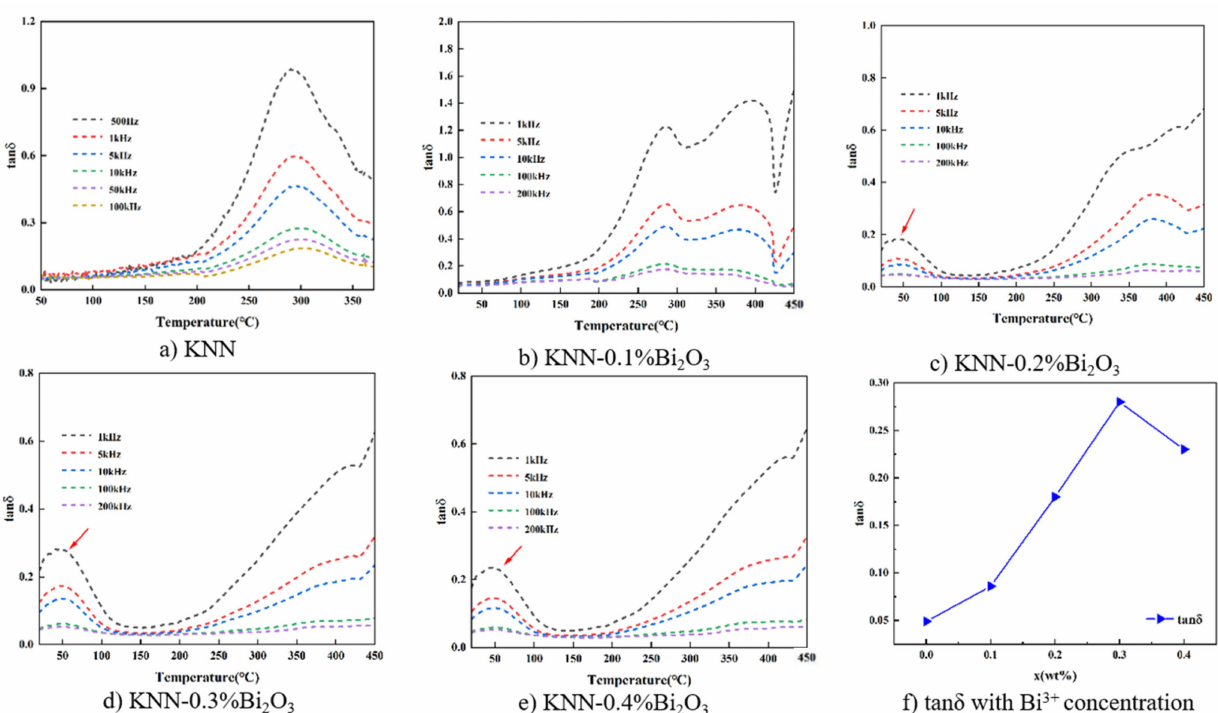
Figure 5. Temperature dependence of dielectric loss tan δ for KNN-x%Bi 2 O 3 (x = 0.0, 0.1, 0.2, 0.3, 0.4) ceramics.